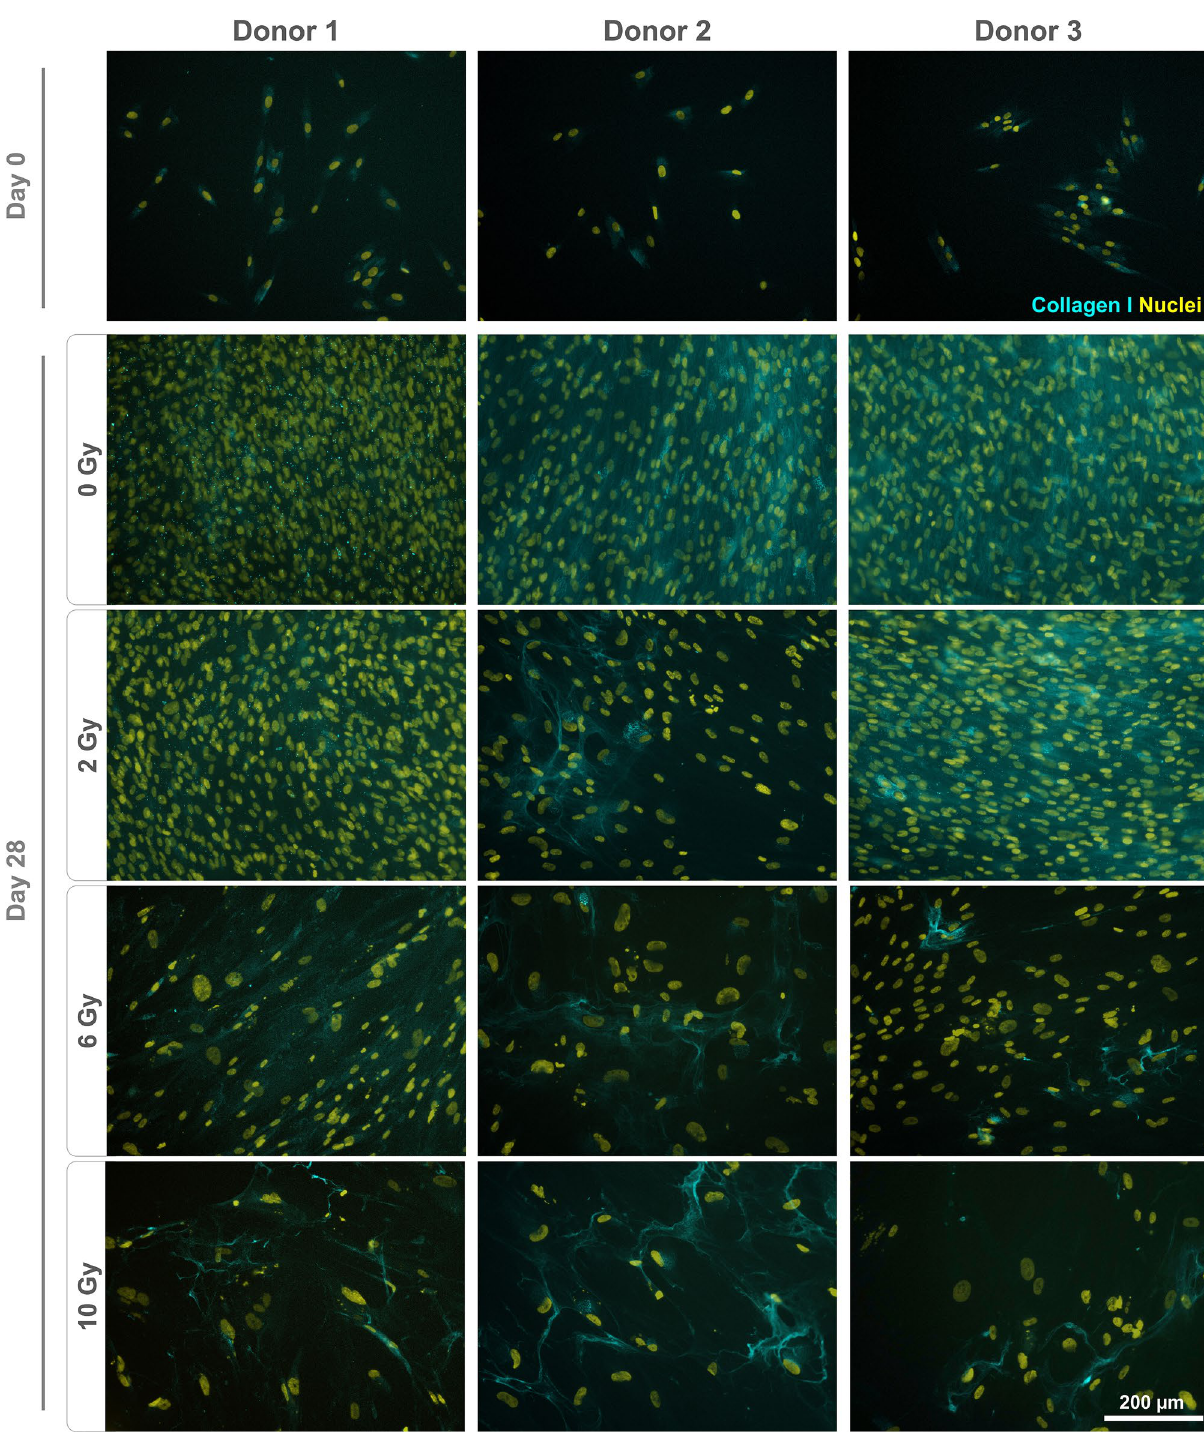
Figure 6. Immunostaining of irradiated JHOBs for collagen I. Cells were irradiated with 2, 6 and 10 Gy or sham, and stained for expression of collagen I (cyan) after 28 days of cultivation in osteogenic medium. Non- treated cells on day 0 were used as a control. Nuclei were counterstained with DAPI